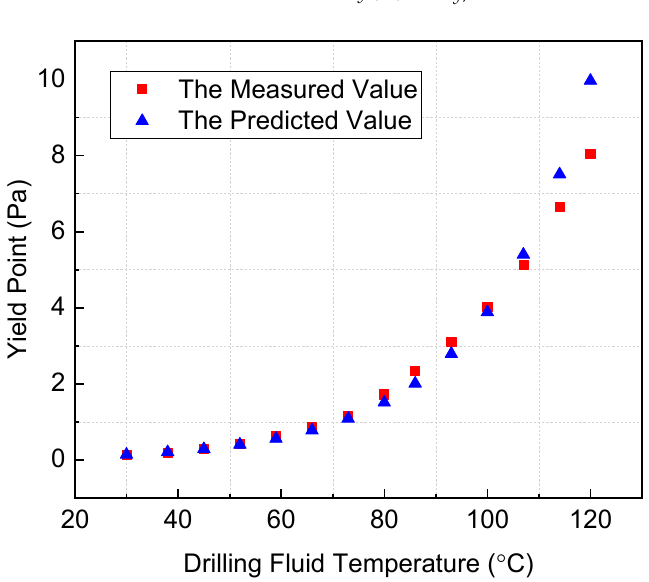
Figure 6. Comparison of predicted and measured yield point of drilling fluids. The plastic viscosity of the drilling fluid measured by Clark does not change monoton- ically with temperature, and the model established by Equation (27) is ineffective. After comparing linear, exponential, logarithmic, polynomial and other models, it was found that the prediction accuracy of the polynomial model was higher, and the modeling was simple and easy to use. The drilling fluid plastic viscosity prediction model is as follows. The applicable temperature range is 30–120 ◦ C, and the average prediction accuracy is 97.02%. The results are shown in Figure